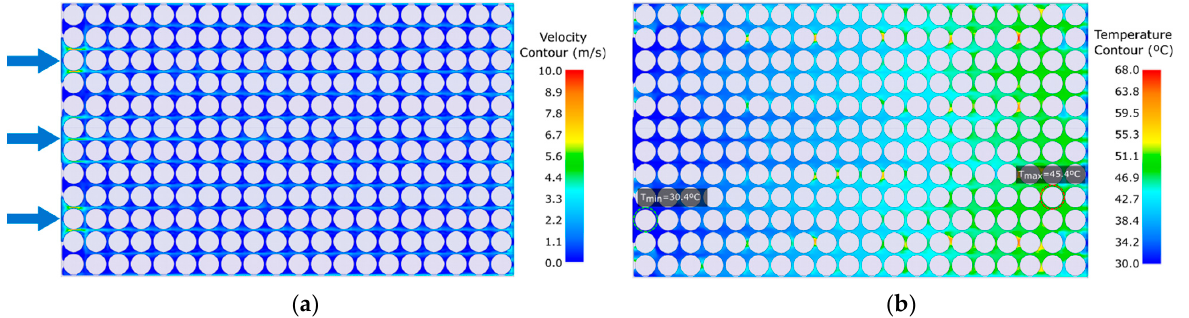
Figure 5. The contour of ( a ) velocity and ( b ) temperature of 3 inlet model.